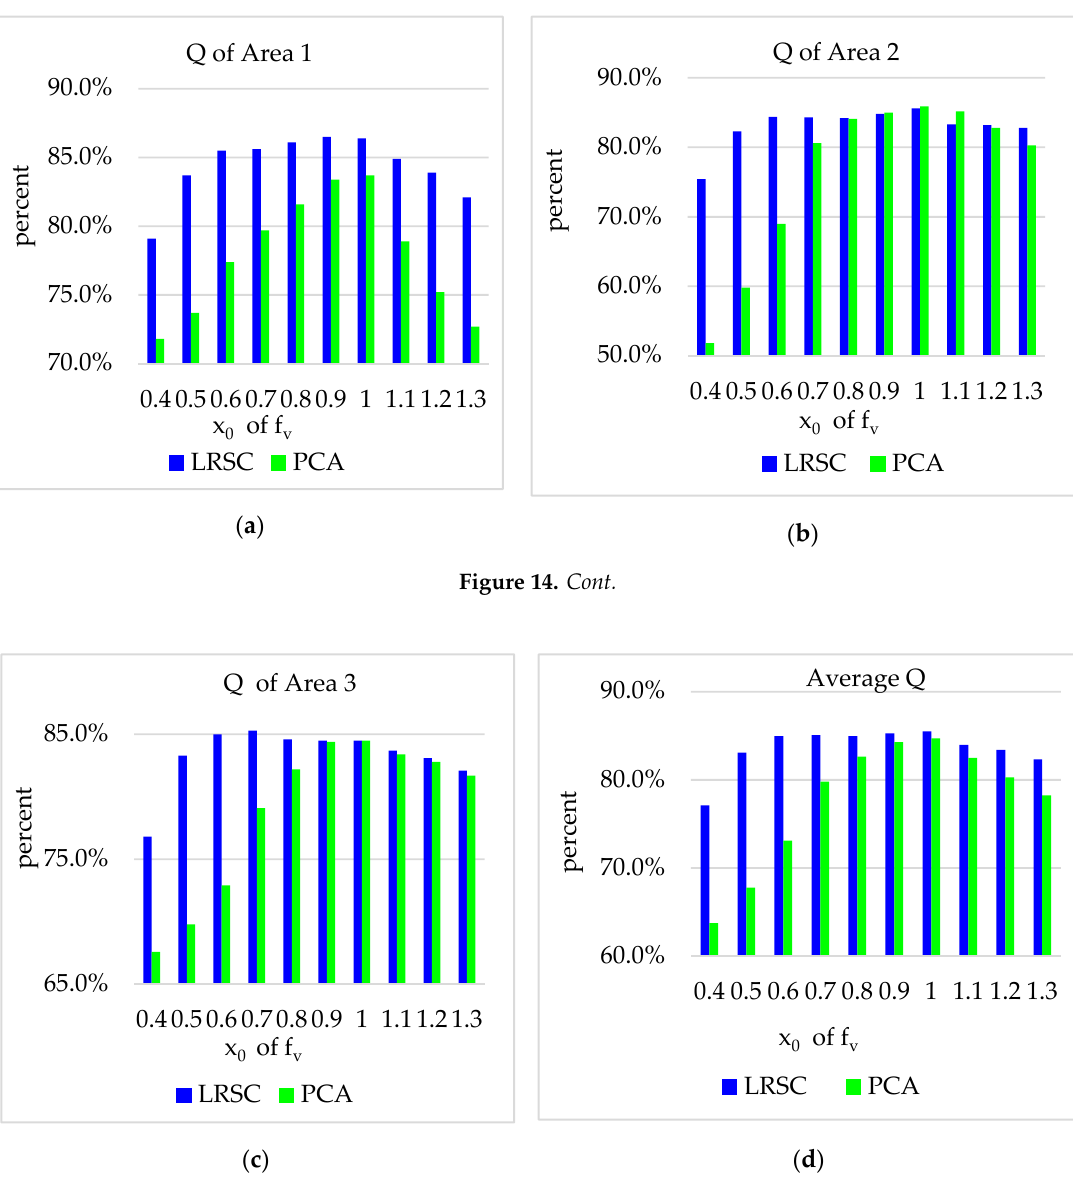
Figure 14. Q (quality) metric on a per-area level of extraction results. ( a ) Q of Area 1; ( b ) Q of Area 2; ( c ) Q of Area 3; ( d ) Average Q.